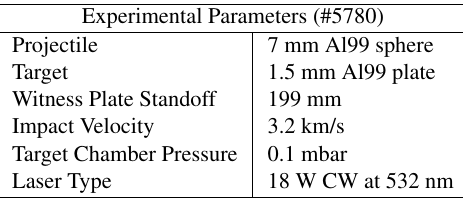
Table 1. Experimental parameters